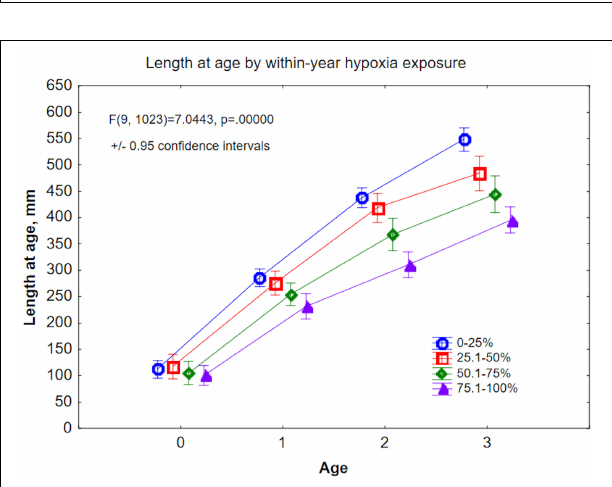
FIGURE 8 | Back-calculated length at age for Ages 0–3, plotted by within-year hypoxia exposure level. Hypoxia exposure is proxied here by Mn/Mg above the age-specific thresholds, expressed as fraction of the otolith annulus.